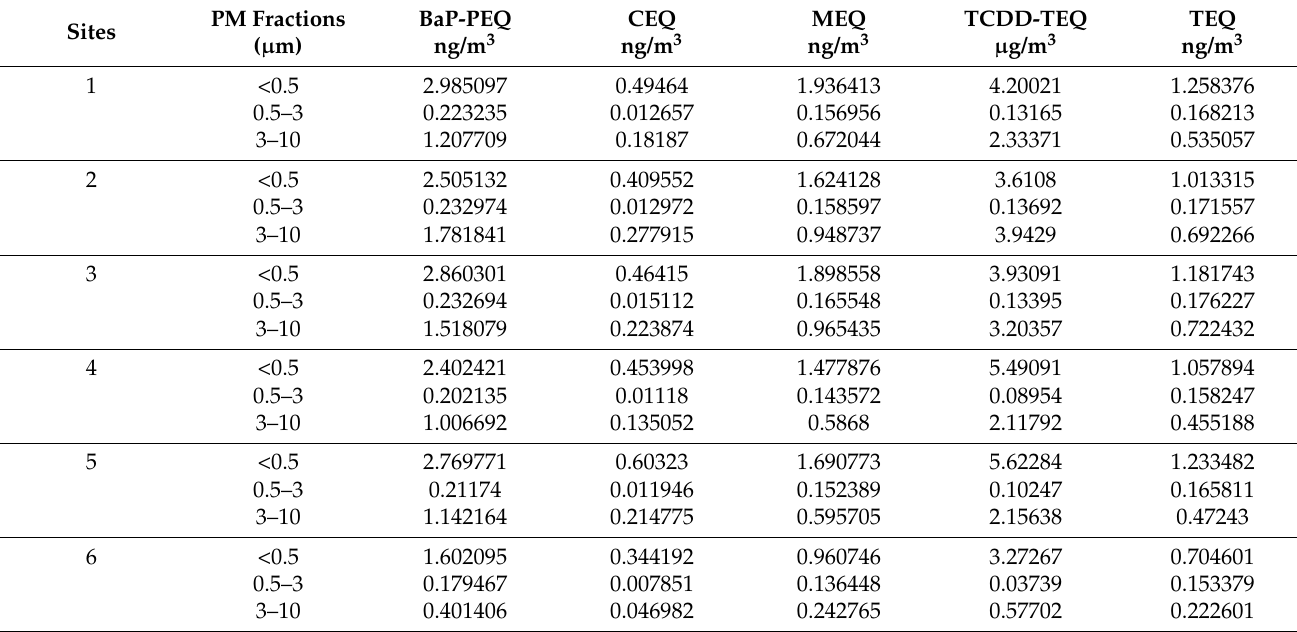
Table 4. Various PAH toxic equivalency measures for each PM fraction according to the site of sampling.